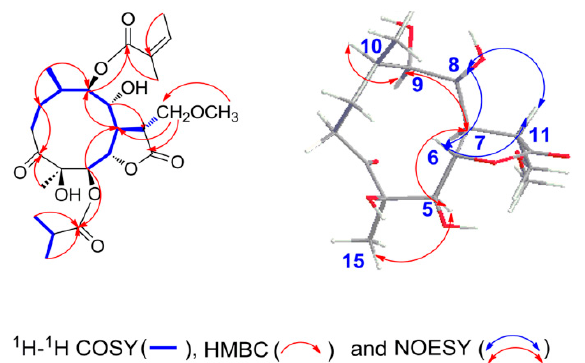
Figure 3. Key 1 H − 1 H COSY, HMBC, and NOESY correlations of 1 . The relative configuration of 1 was determined by analysis of NOESY data (Figure